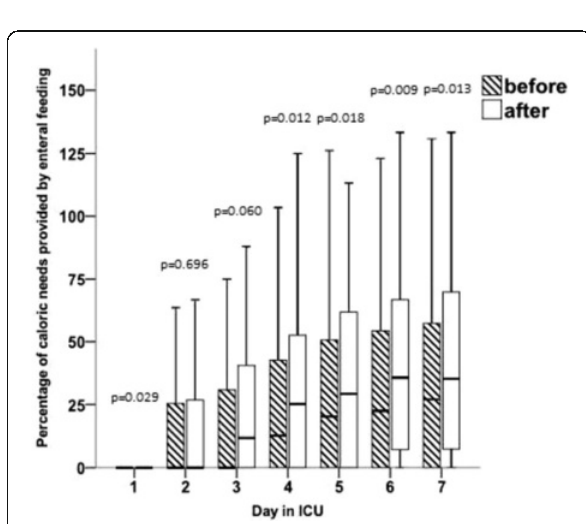
Fig. 25 (abstract A54). Daily proportions of enteral calories